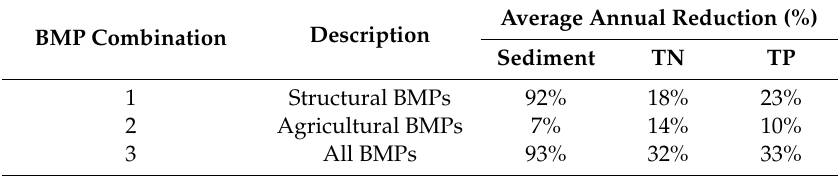
Table 6. E ff ectiveness of combination BMPs in sediment and nutrient loadings at the watershed